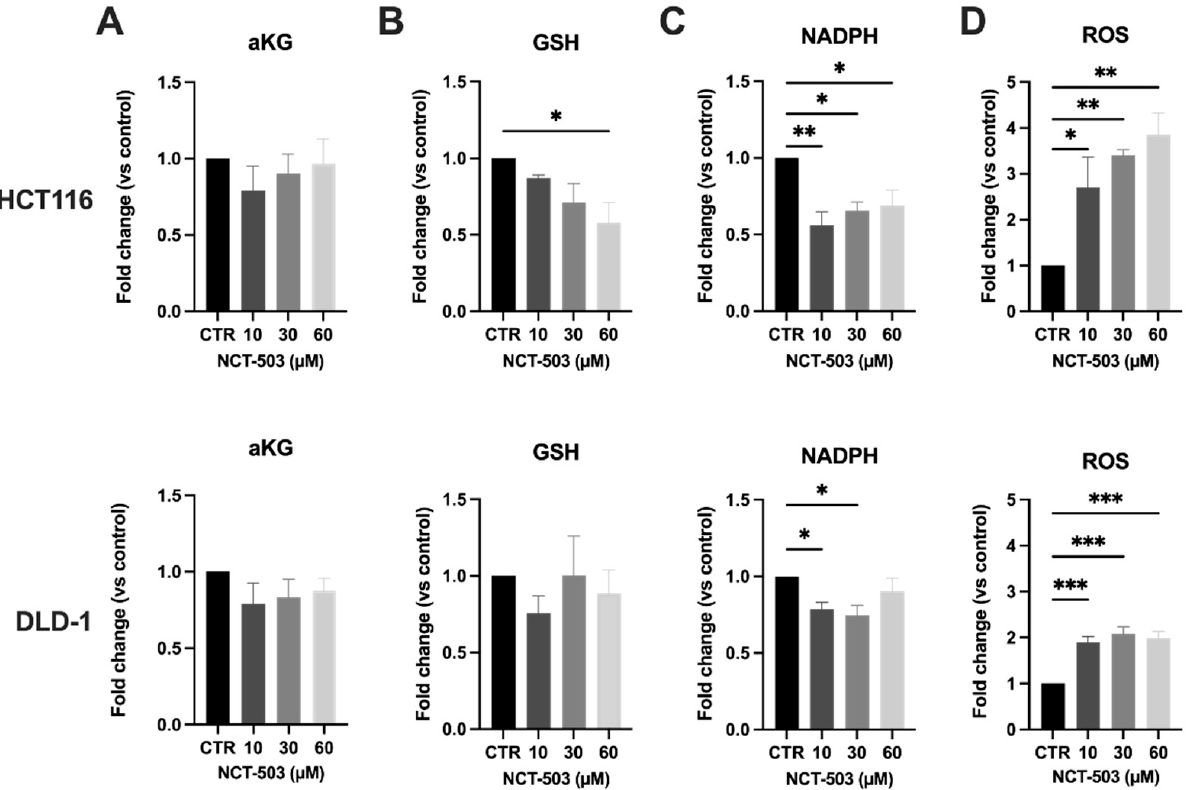
Figure 3. PHGDH inhibition does affect end-metabolites aKG, GSH, NADPH and redox balance in normoxic CRC cells. HCT116 (top) and DLD-1 (bottom) cells were treated with NCT-503 for 5 h at indicated concentrations. ( A ) aKG levels—normalized to control; ( B ) GSH levels—normalized to control; ( C ) NADPH levels—normalized to control; ( D ) ROS levels—normalized to control. Data are shown from at least four replicates as mean ± SEM. One-way ANOVA with Dunnett’s multiple comparison test was used to calculate statistics: * p < 0.05, ** p < 0.01, *** p < 0.001.